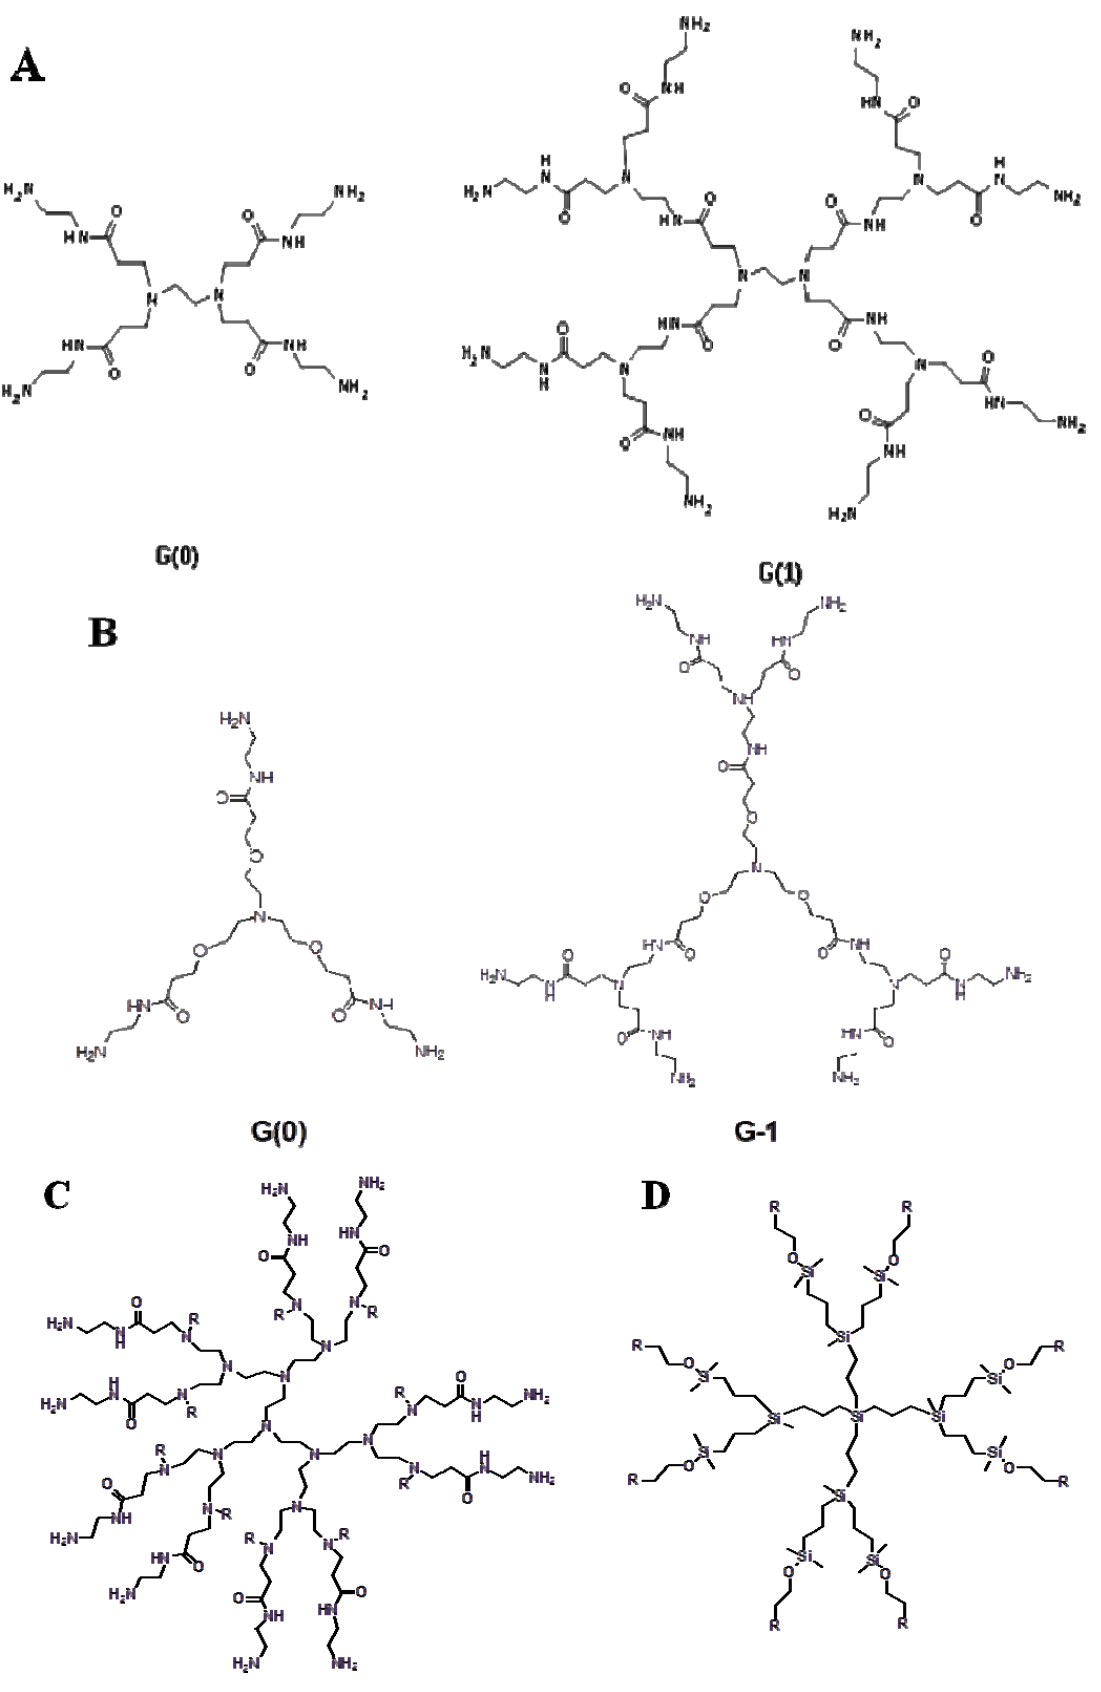
Figure 3. Schematic representation of PAMAM dendrimers with- A , ethylenediamine; B , triethanolamine; C , PEI-PAMAM as the core; D , a carbosilane dendrimer of second